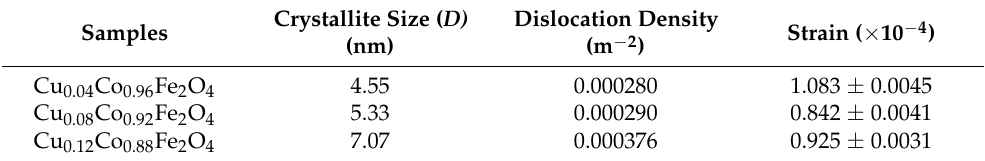
Table 2. Dislocation density, crystallite size, and microstrain of Cu 2+ -doped CFO